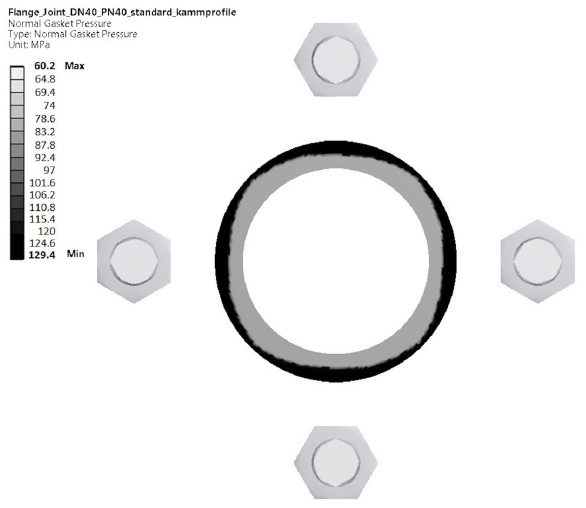
Figure 12: Contact stress distribution on the gasket surface in case of the joint gasketed with the standard gasket